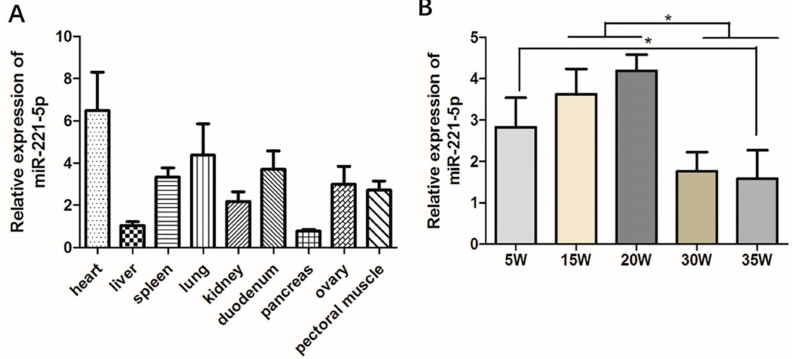
Figure 2. Spatiotemporal expression profile of gga-miR-221-5p. ( A ) The relative expression of gga-miR-221-5p in di ff erent tissues. ( B ) The relative expression of gga-miR-221-5p in di ff erent liver stages. β -actin was used as an internal reference gene to estimate the relative expression of mRNA. U6 was used as an internal reference gene to estimate the relative expression of miRNA. Data are represented as mean ± SD ( n = 6). * means 0.01 < p <